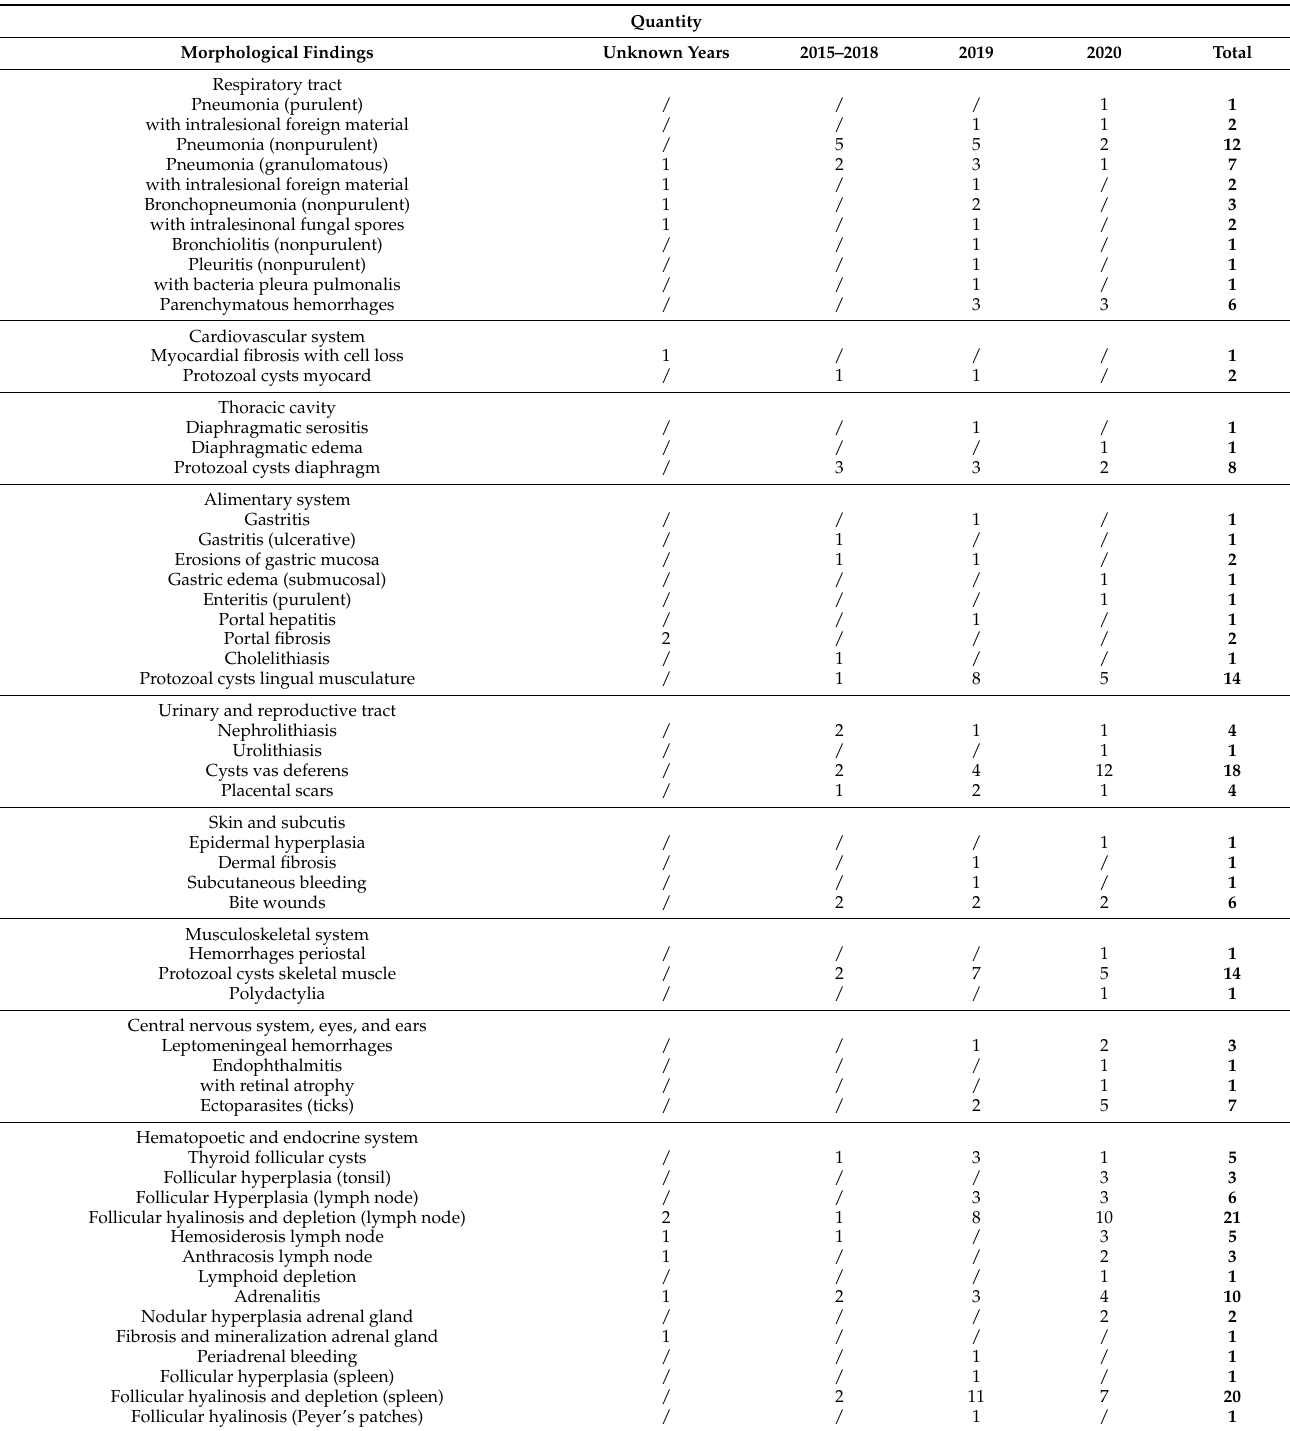
Table 3. Histopathological findings in Eurasian otters from Schleswig-Holstein between